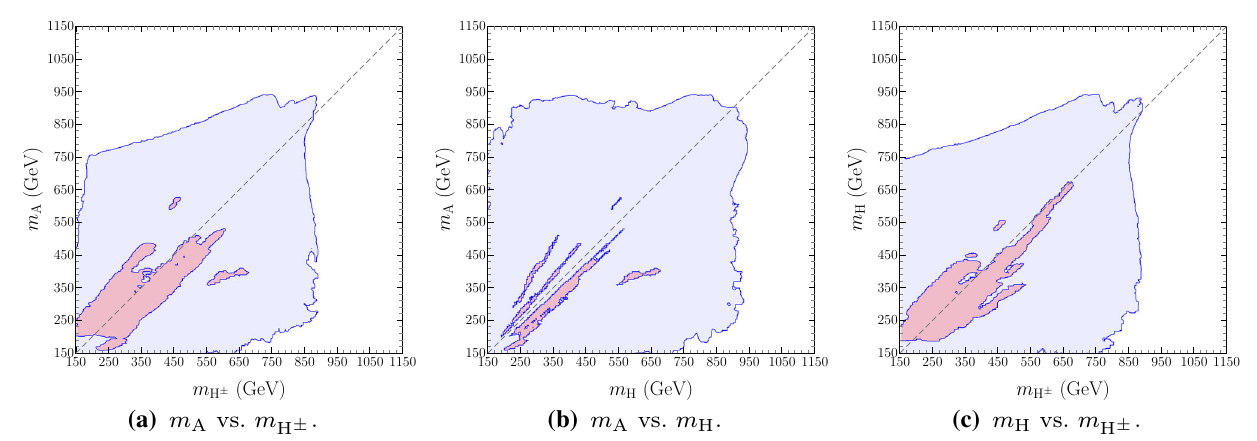
Fig. 8 Regions allowed at 99% CL by the requirements of the full analysis (see Fig.